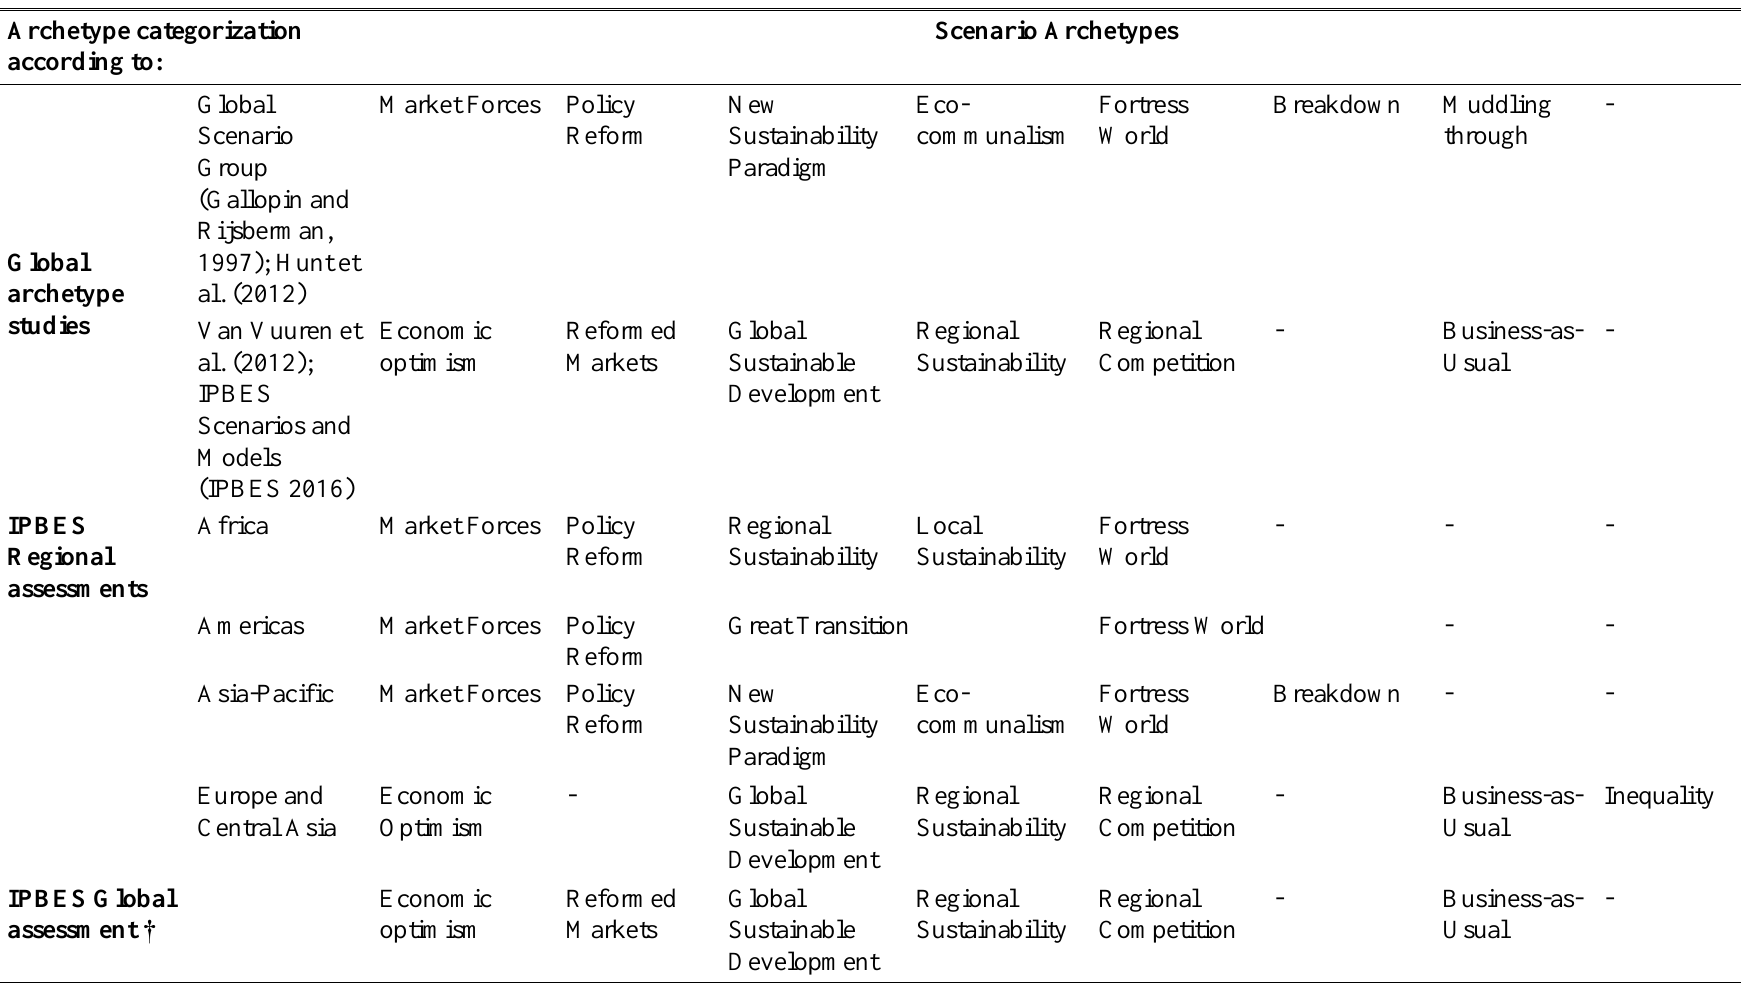
Table A3.1: Summary of scenario archetypes used in individual IPBES regional assessments and their correspondence to selected global scenario archetype studies. For details of the regional versions of the scenario archetypes, please see Biggs et al. 2018, Gundimeda et al. 2018, Harrison et al. 2018, 2019, Klatt et al.